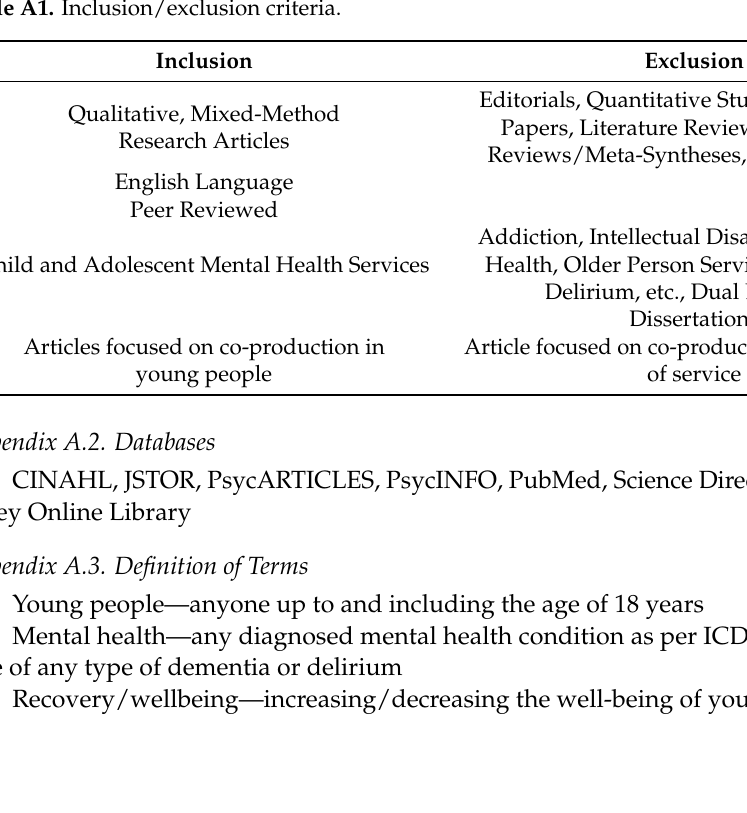
Table A1. Inclusion/exclusion